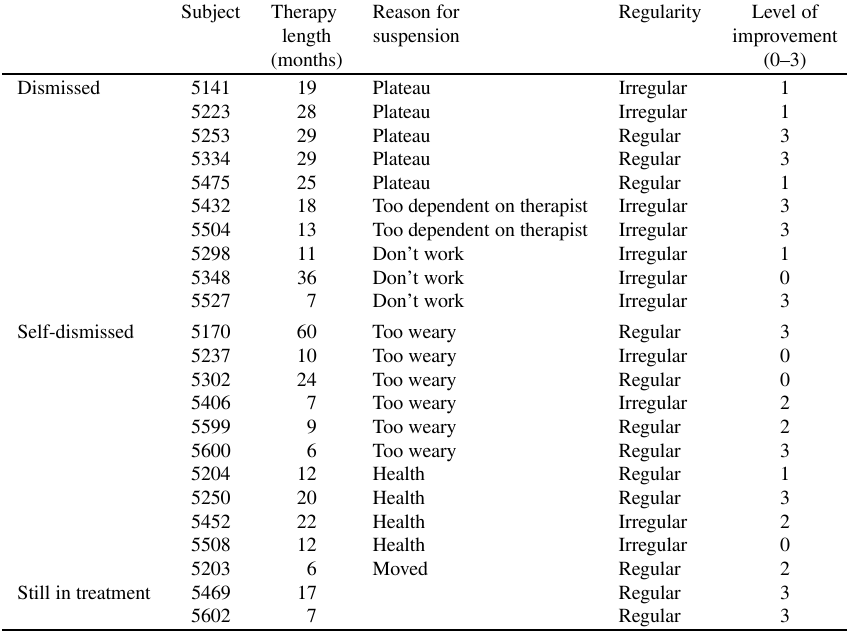
Table 8 Therapy length, suspension reasons, regularity of home-treatment and level of